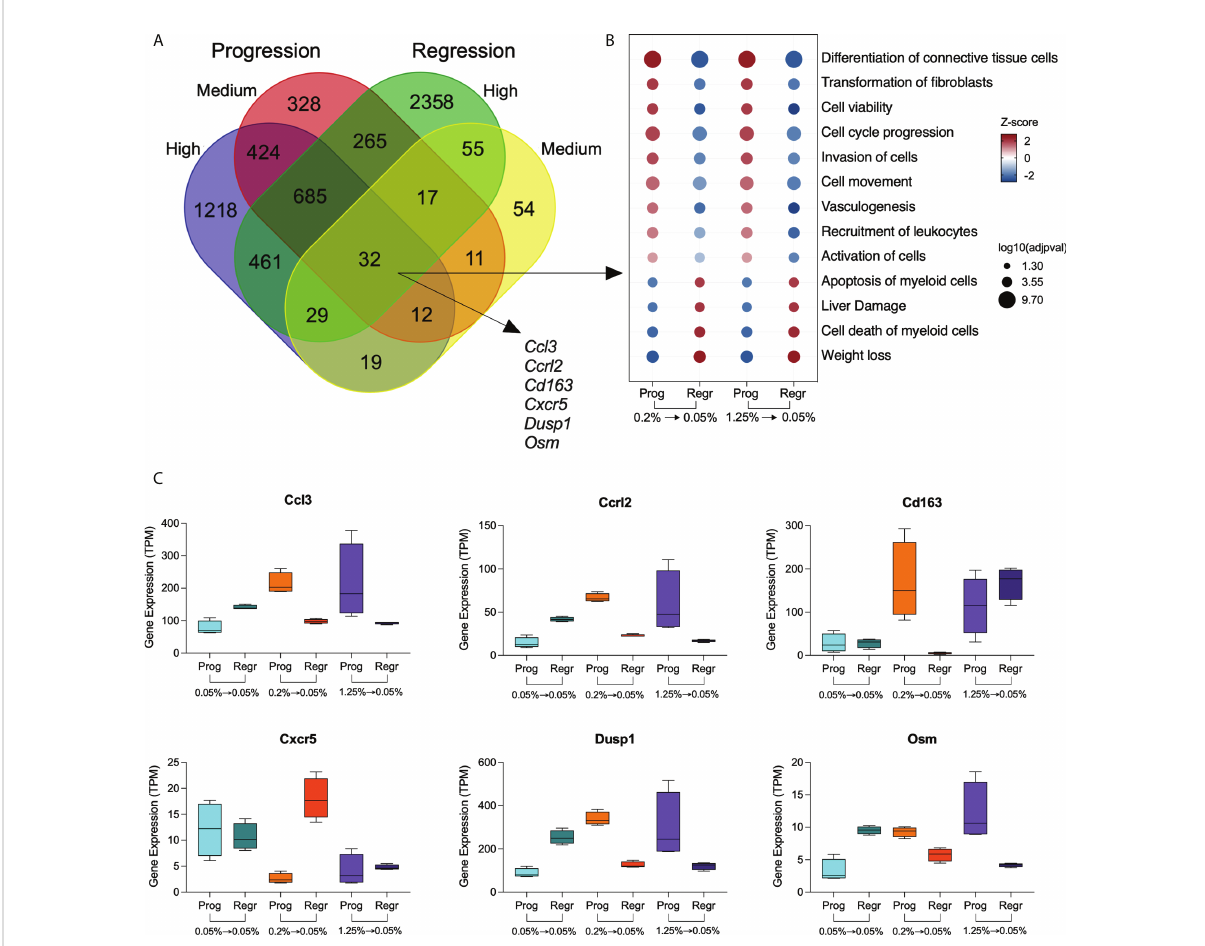
FIGURE 3 Genes modulated by dietary cholesterol in hepatic macrophages. (A) Venn diagram shows the overlapping differentially expressed genes among the comparison groups. The high and medium cholesterol groups were compared to the low cholesterol group during progression (Prog) and regression (Regr) phases. Thirty-two genes were commonly expressed by the four comparison groups. (B) Bubble plot shows the biological processes derived from the 32 genes commonly expressed genes by the four groups. Analysis performed using Ingenuity Pathway Analysis (IPA). (C) Expression of six genes with immunological signi fi cance were highlighted are shown in all six dietary groups included in this study. Prog, Progression phase; Regr, Regression